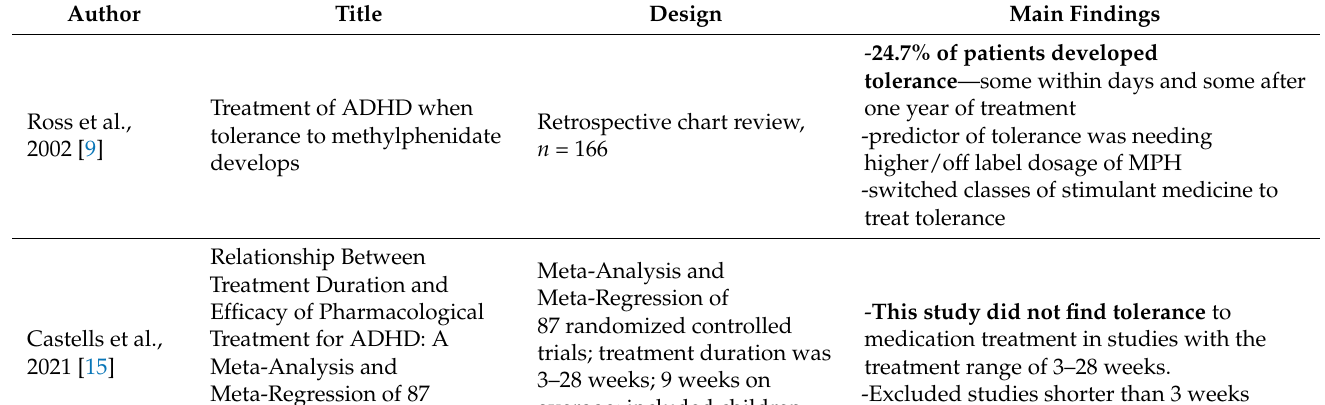
Table 1. Summary of Clinical Research on Tolerance to Stimulant